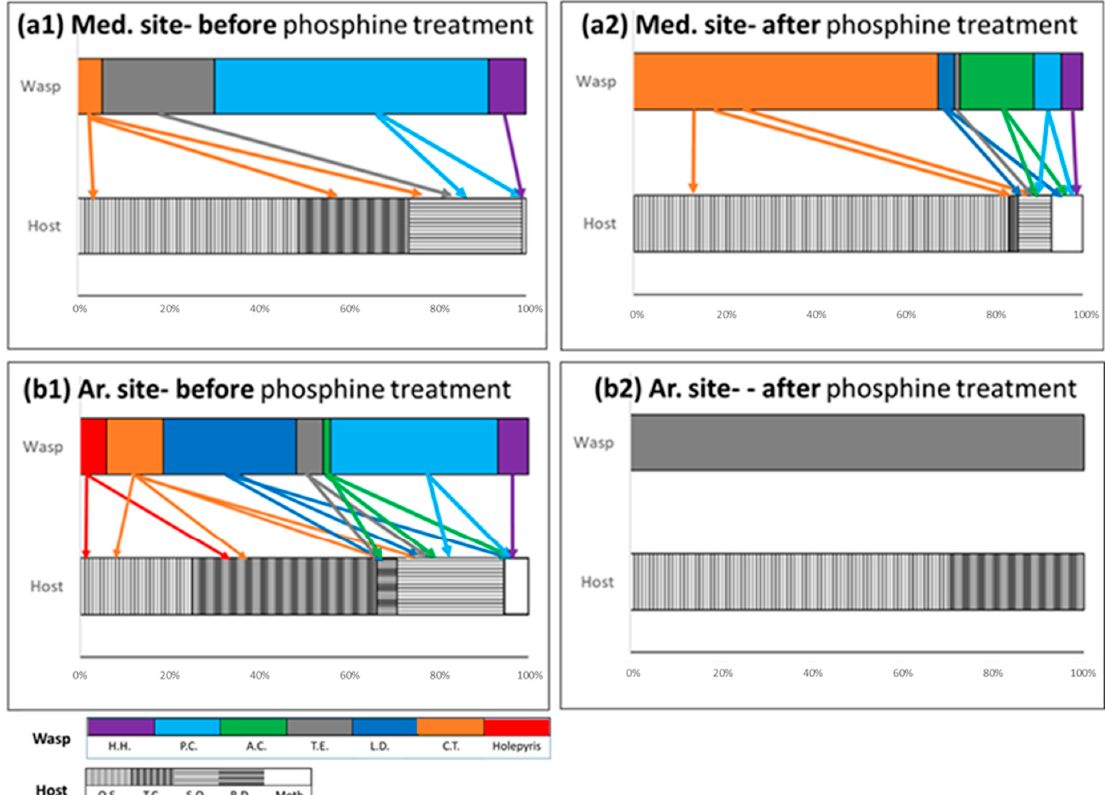
Figure 3. Wasp and host abundance (%) at the ( a ) Med. site and the ( b ) Ar. site ( 1 ) before and ( 2 ) after the application of phosphine. Arrows indicate on parasitoid wasp- host interaction based on Table 1. OS— Oryzaephilus surinamensis ; SO— Sitophilus oryzae ; TC— Tribolium castaneum ; RD— Rhyzopertha dominica ; Moths: Plodia interpunctella and Ephestia cautella. Wasps: CT— Cephalonomia tarsalis, Hol.—Holepyris sp., HH— Habrobracon hebetor , LD— Lariophagus distinguendus , PC— Pteromalus cerealellae , TE— Theocolax elegans , AC— Anisopteromalus calandrae .